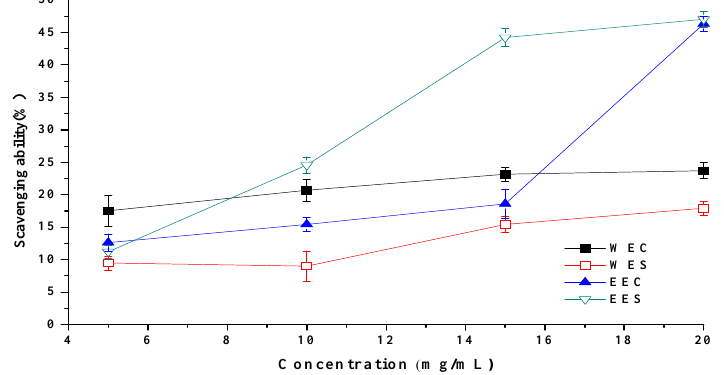
Each value is expressed as mean ± S.D. (n =